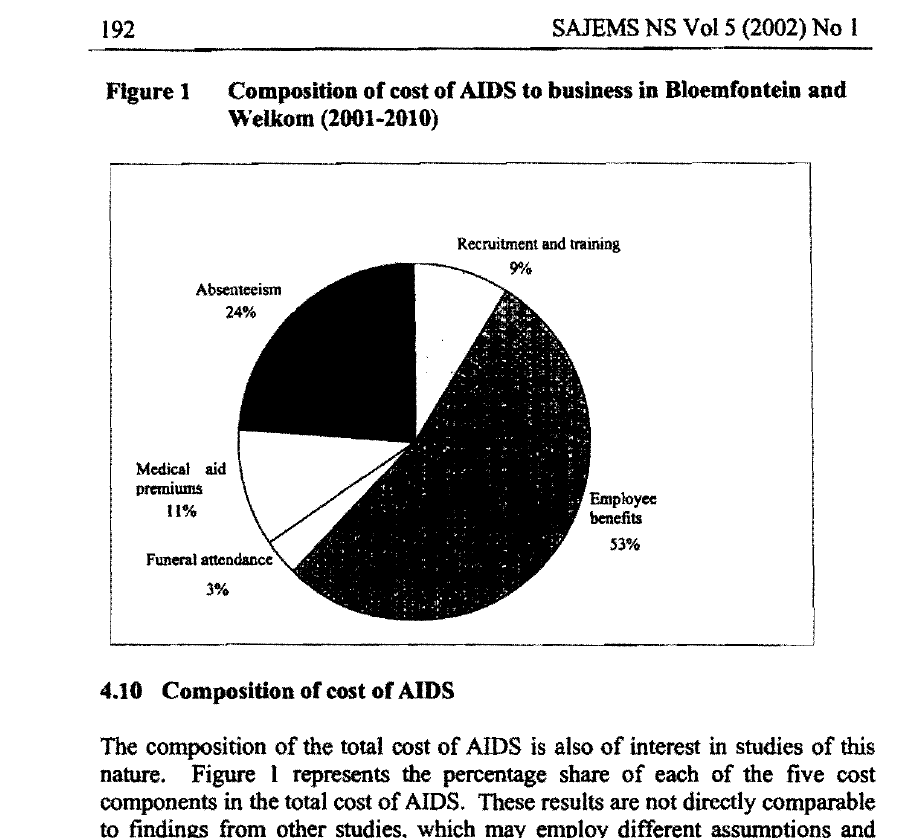
Composition of cost of AIDS to business in Bloemfontein and Welkom (2001-2010)